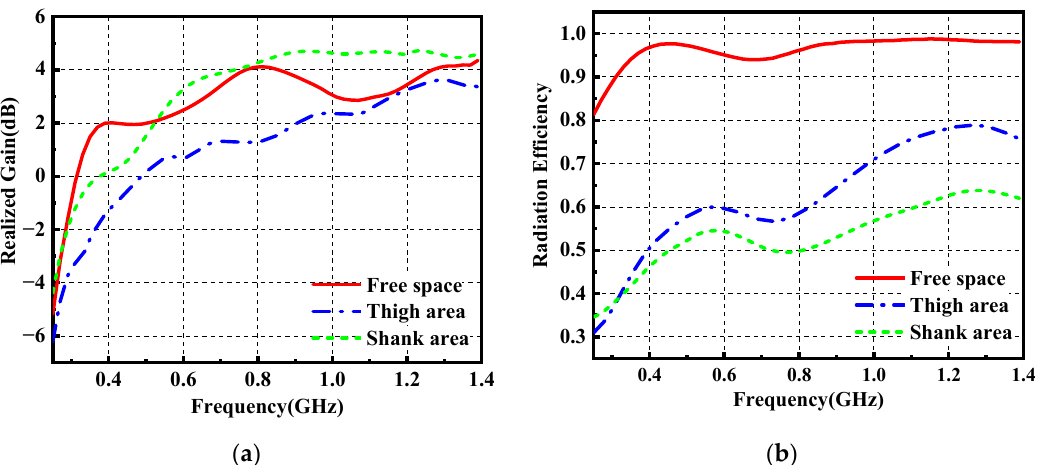
Figure 11. Realized gain ( a ) and radiation efficiency ( b ) of the wearable antenna in free space, thigh area and shank area.